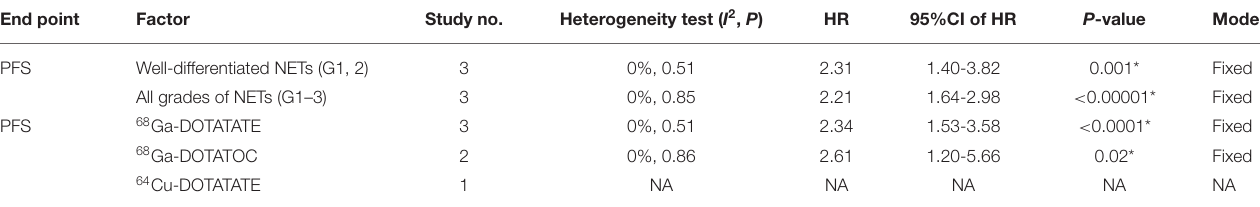
TABLE 3 | Results of subgroup analysis in PFS based on TTV.